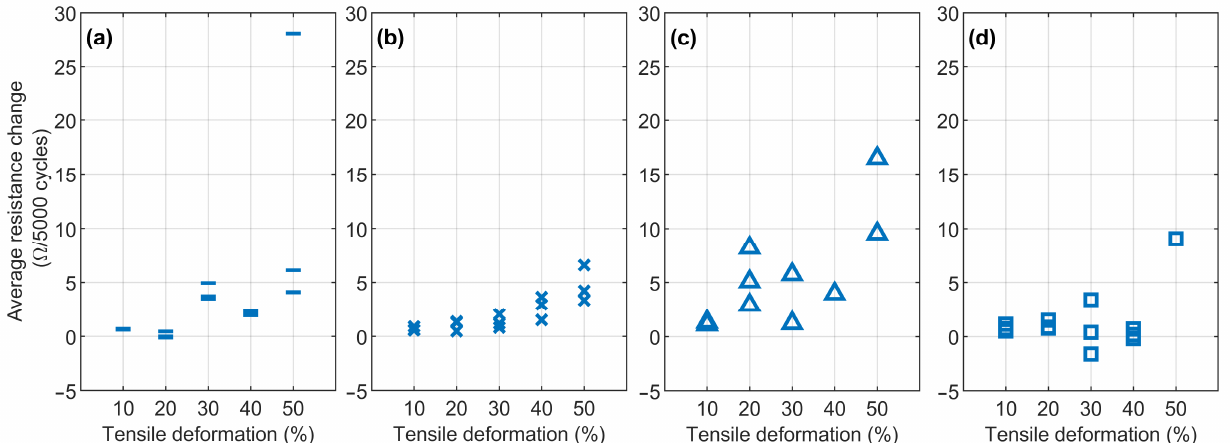
Figure 8. Average resistance changes between cycles in the last 5000 test cycles: ( a ) series with 1 thin CFC, ( b ) series with 2 thin CFCs, ( c ) series with 3 thin CFCs, and ( d ) series with 1 thick CFC.